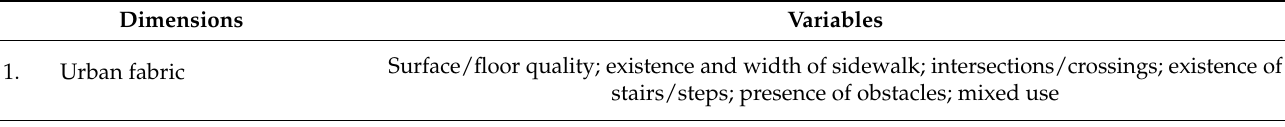
Table 1. Dimensions and related urban variables of the WIEH .